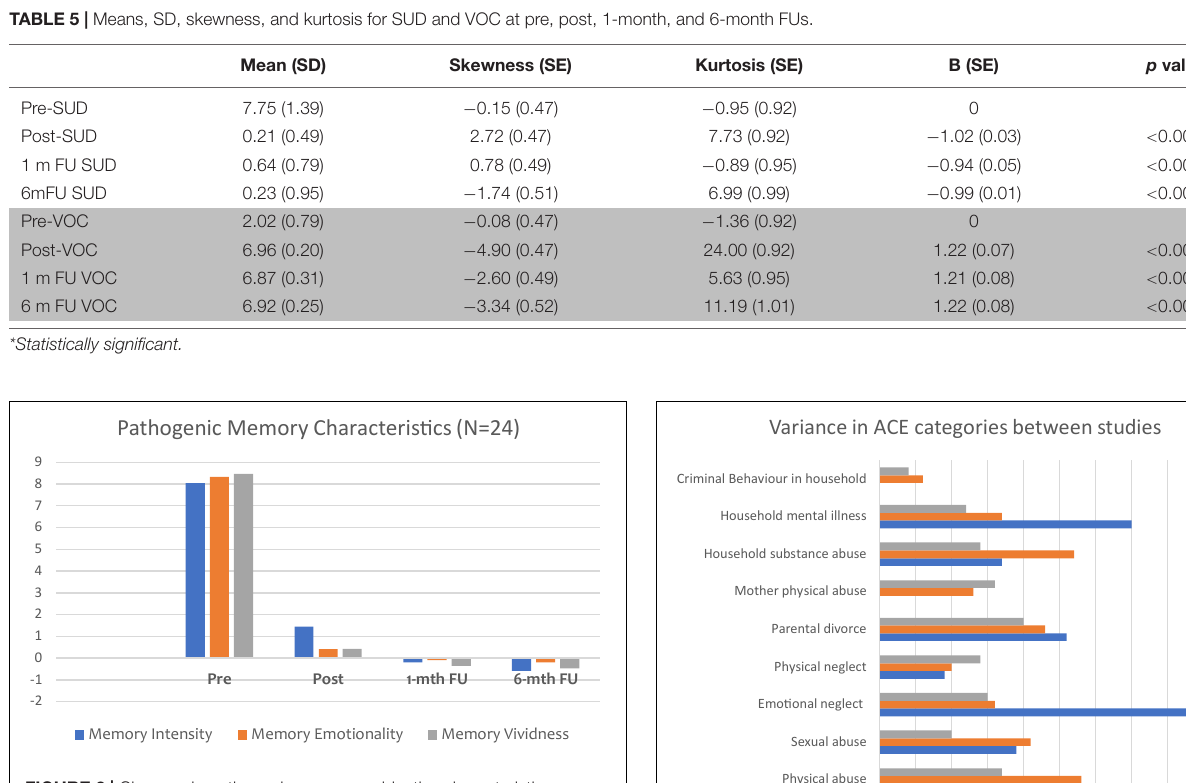
FIGURE 2 | Changes in pathogenic memory subjective characteristics.